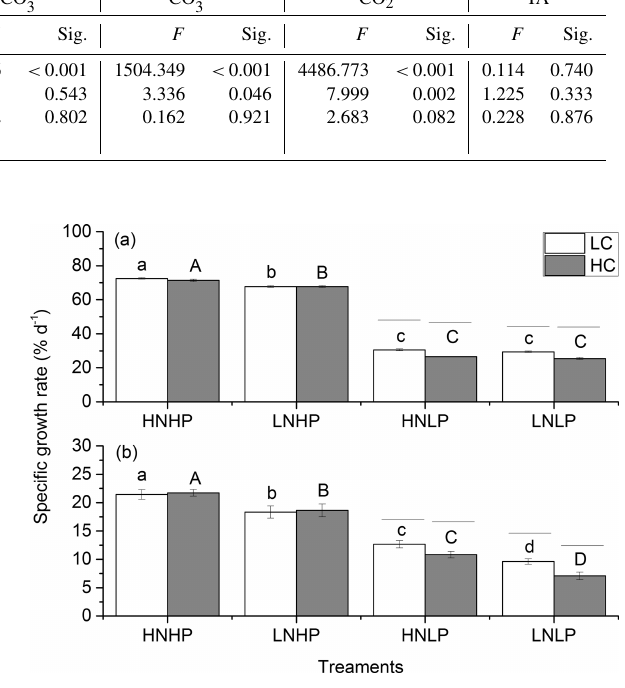
Figure 2. Specific growth rate (%d − 1 ) of young (a) and adult (b) U. linza grown under various conditions. The specific growth rate for young and adult thalli were calculated based on the initial and final length (for young thalli over a 16-day culture) or mass (for adult thalli over a 9-day). LC, 400µatm; HC, 1000µatm; LN, 6.1µmolL − 1 ; LP, 0.2µmolL − 1 ; HN, 106.1µmolL − 1 ; HP, 10.2µmolL − 1 . The error bars indicate the standard deviations ( n = 3). Different letters (lower case for LC and capital for HC) above the error bars represent significant differences ( P < 0.05) among nu- trient treatments while horizontal bars represent significant differ- ences ( P < 0.05) between LC and HC within a nutrient